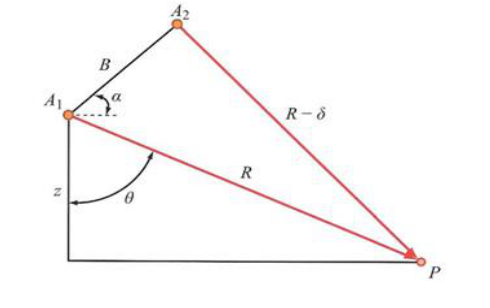
Figure 2. Geometry of flat earth phase In Fig. 2, A1, A2 represents antenna’s positions of two times imaging respectively, the distance between the two antennas is defined as baseline B, 𝛼 represents the angle between baseline and horizontal surface, R and R- 𝛿 are the slant range